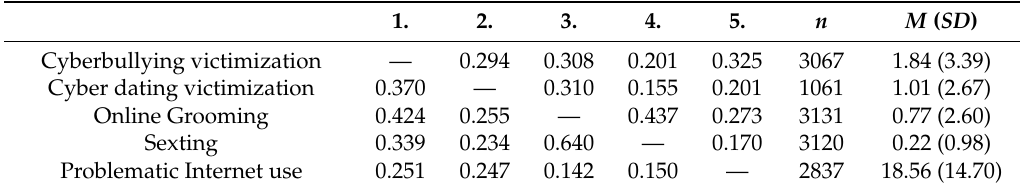
Table 3. Total correlations between the risks of the study in boys and